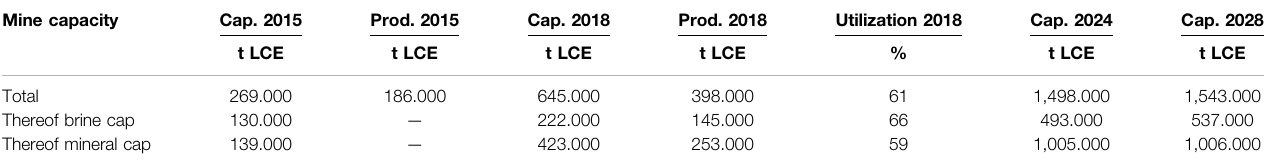
TABLE 4 | Lithium mining and production capacities for selected years (Roskill, 2019).